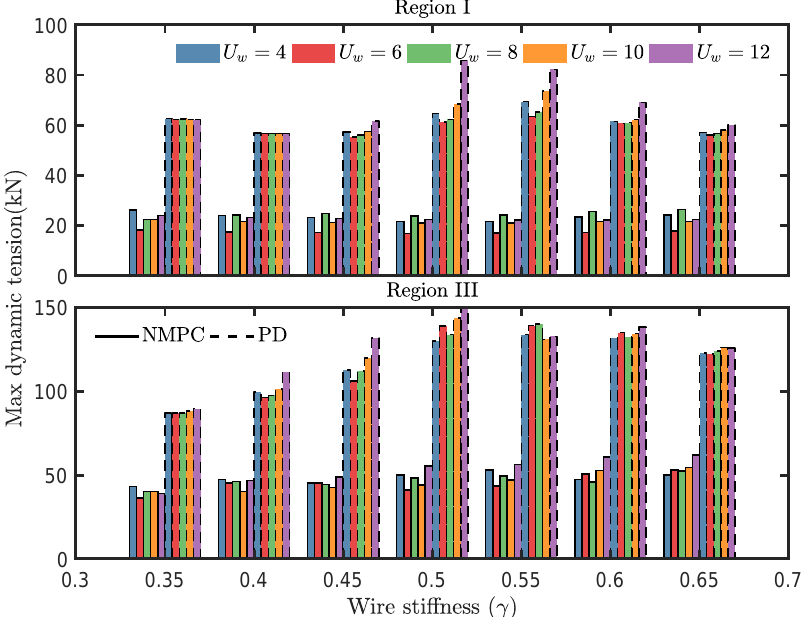
Figure 16. Comparison of the maximum dynamic tensions resulted by the NMPC and PD controllers in a turbulent wind field, mean wind speed = 4–12 m/s (upper: Region I, lower: Region